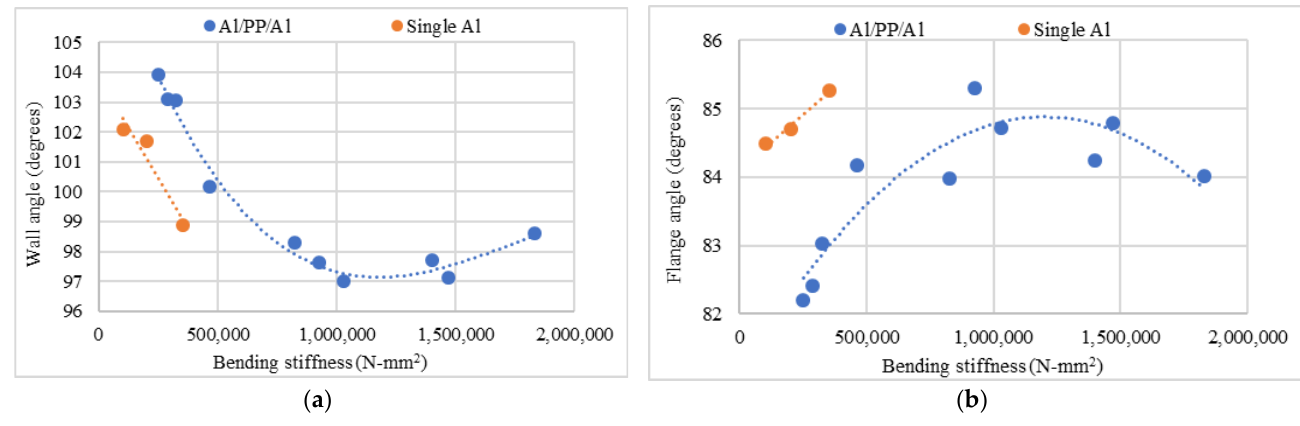
Figure 7. ( a ) Wall angle vs. bending stiffness of single Al and Al/PP/Al laminates ( b ) Flange angle vs. bending stiffness of single Al and Al/PP/Al laminates.